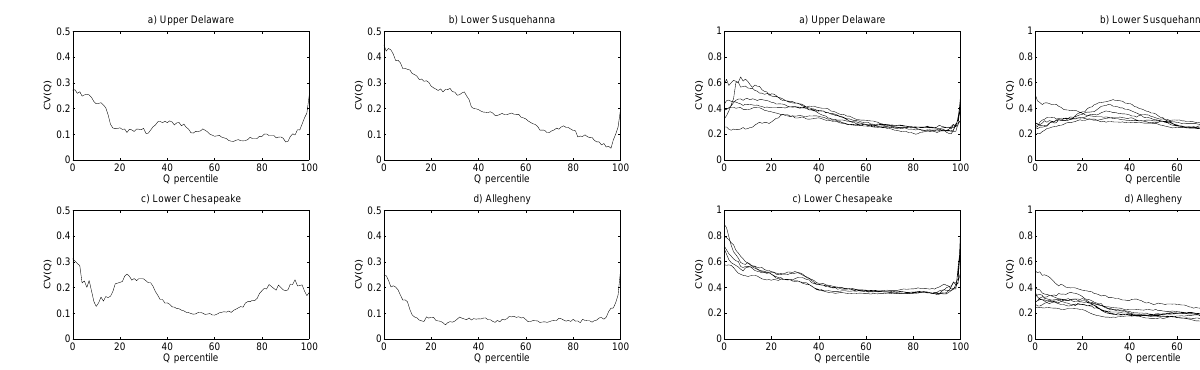
Fig. 4. Coefficients of variation of catchment streamflow percentiles within (a) Upper Delaware, (b) Lower Susquehanna, (c) Lower Chesapeake, and (d) Allegheny basin.